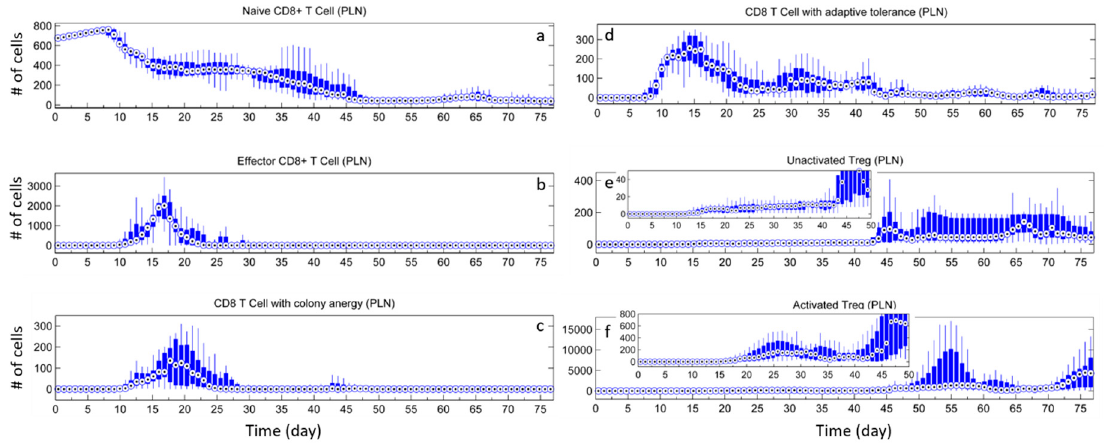
Figure A4. Simulation results for case with induced Tregs (case IV). There are no initial Tregs but conversion ability of CD4 + T cells. The number of ( a ) naive CD8 + T cells, ( b ) effector CD8 + T cells, ( c ) CD8 + T cells with colony anergy, ( d ) CD8 + T cells with adaptive tolerance, ( e ) unactivated Tregs, ( f ) activated Tregs in PLN are shown. Inserts (number of cells vs. time) show small change of cell number in the bottom figures. t = 0 days correspond to 3-week age of mouse.